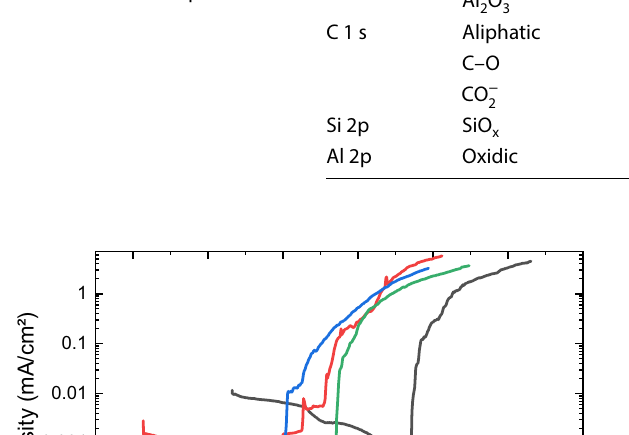
Table 2 Atomic concentrations of the surfaces in the laser surface melted state and additionally covered with a 3 nm and a 6 nm thin PECVD SiO film as derived from high- x resolution element spectra